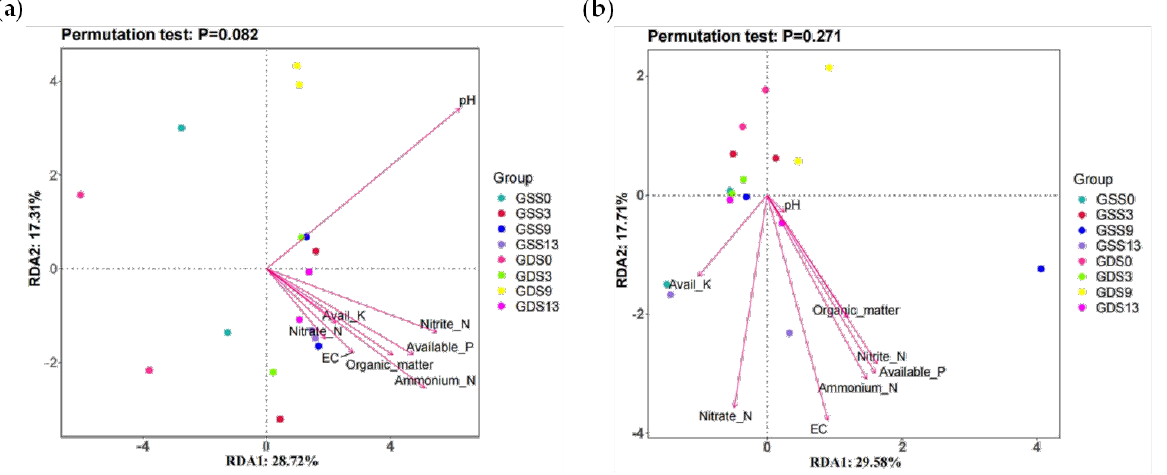
Figure 5. Correlation analysis between soil environmental factors and the structure of bacterial microbial community. ( a ) RDA analysis of bacterial communities; ( b ) RDA analysis of archaeal communities.